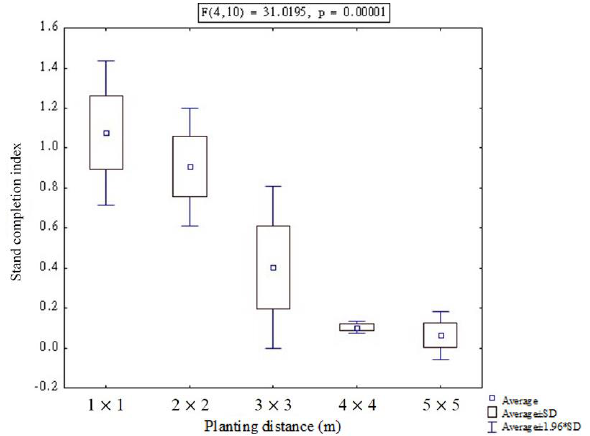
Figure3. The contribute of stand competition index in 5 planting